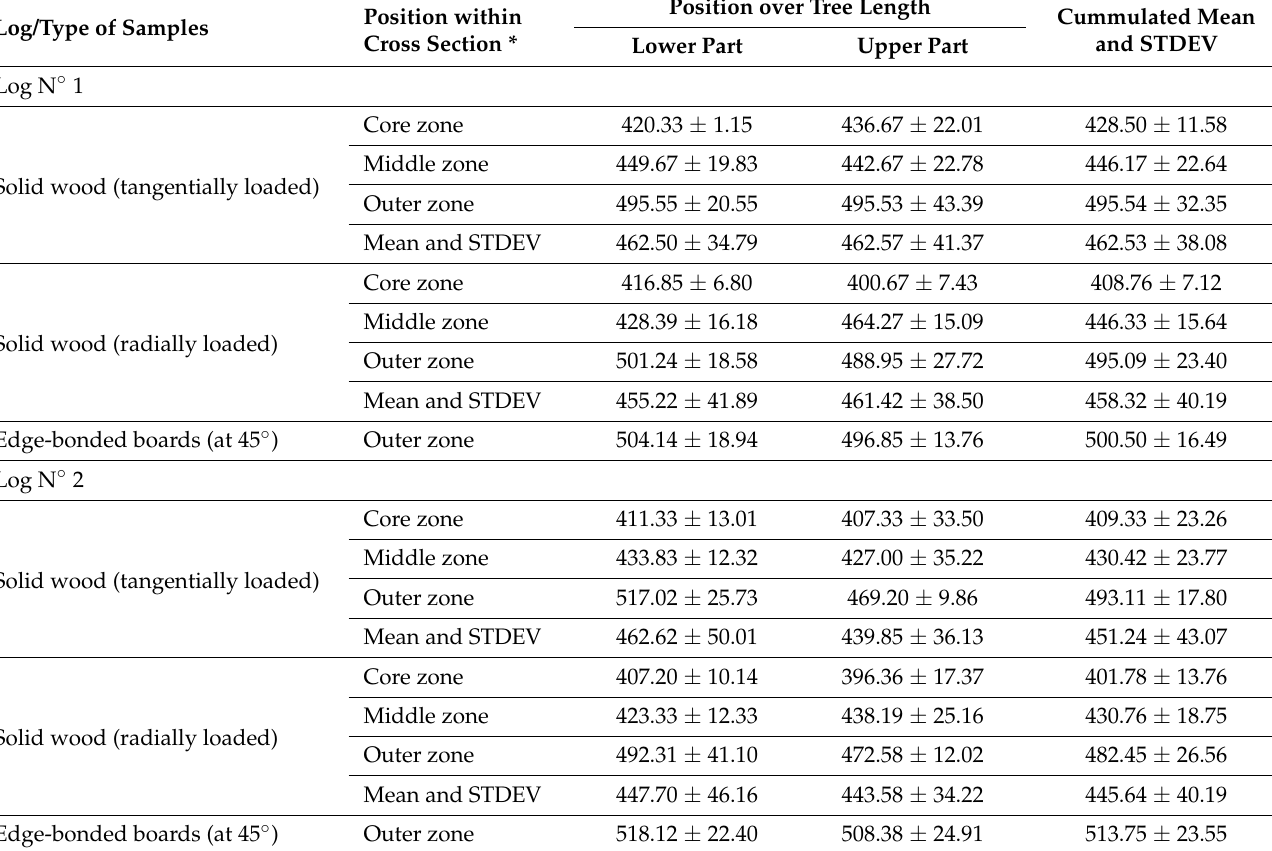
Table 3. Density ρ 12 (in kg/m 3 ) of solid and glued spruce